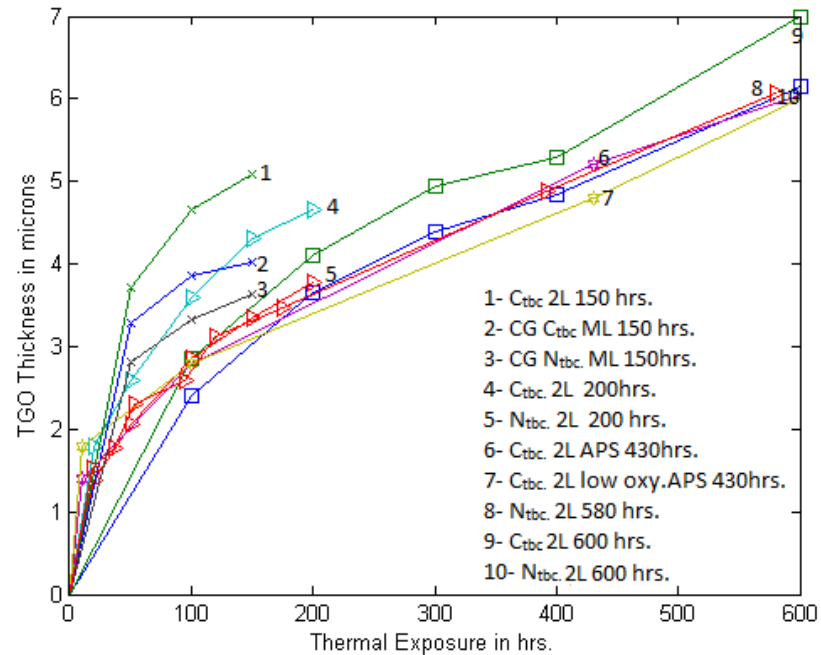
Figure 5. TGO thickness change in N tbc and C tbc under different sintering (oxidation) conditions. L—layer, ML—multilayer, CG—compositionally graded, Low oxy—Oxygen low pressure. Data collected from published sources [17,19,20,32,57].